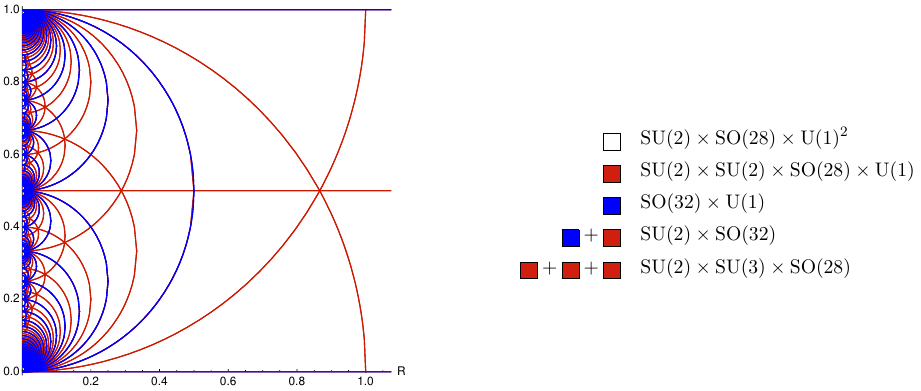
Figure 9. SO(32) heterotic with Wilson line A I = (( A ) 2 ; 0 14 ).